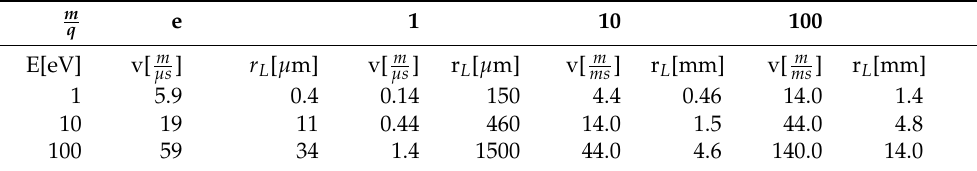
Table 1. Comparing Larmor radii with geometrical dimensions determines whether charged particles (electrons (e) and/or ions with m/q ratio of 1, 10, 100 atomic mass-to-charge units) are magnetized.